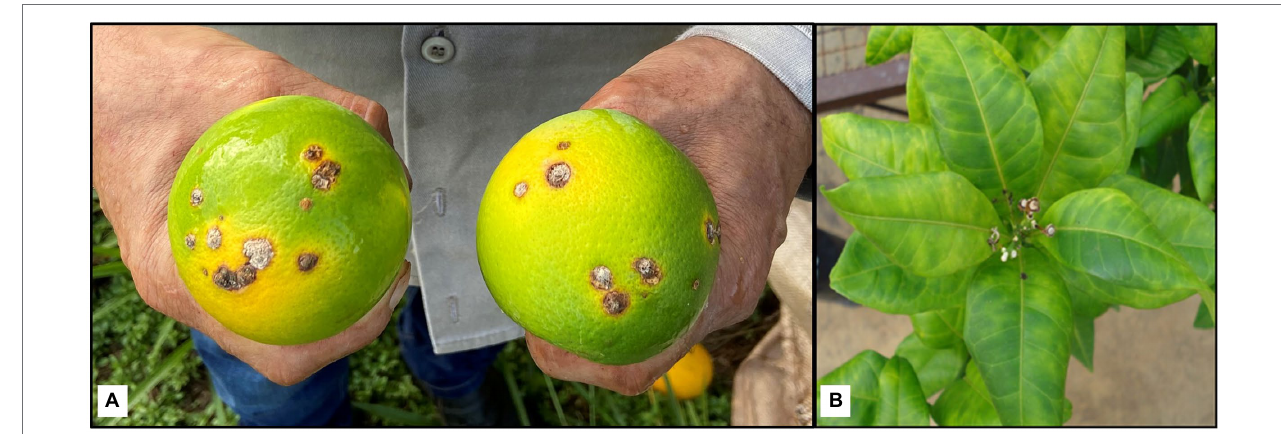
FIGURE 3 | Citrus canker lesions in harvested fruit (A) and huanglongbing (HLB) symptoms in leaves (B) of sweet orange selections in Guairaçá, state of Paraná,